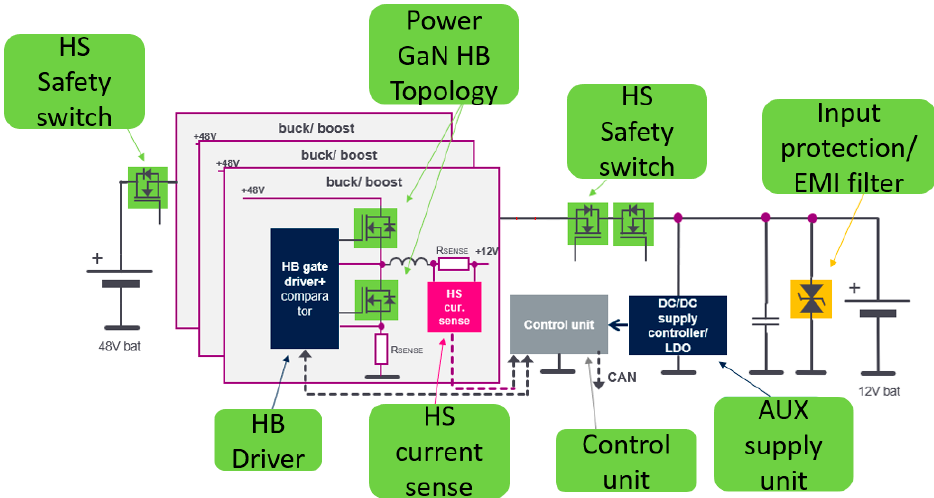
Figure 14. Block diagram of interleaved 48–12 V converter.